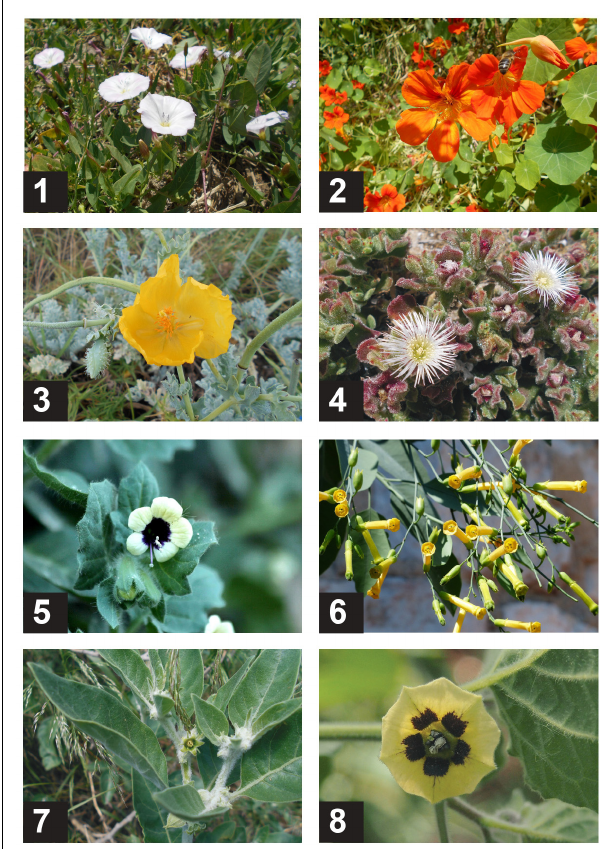
FIGURE 1 | Images of the flowers of all species pairs studied on Mallorca (pictures on the left represent native species whereas their corresponding partners are shown at right). (1) Convolvulus arvensis L. (Convolvulaceae) and (2) Tropaeolum majus L. (Tropaeolaceae) in Torrent d’Esporles are pair 1; (3) Glaucium flavum Crantz (Papaveraceae) and (4) Mesembryanthemum crystallinum L. (Aizoaceae) in Ca’n Pere Antoni are pair 2; (5) Hyoscyamus albus L. and (6) Nicotiana glauca Graham; and (7) Withania somnifera L. and (8) Physalis peruviana L. (Solanaceae) in Torrent de Sa Riera are pair 3 and 4,